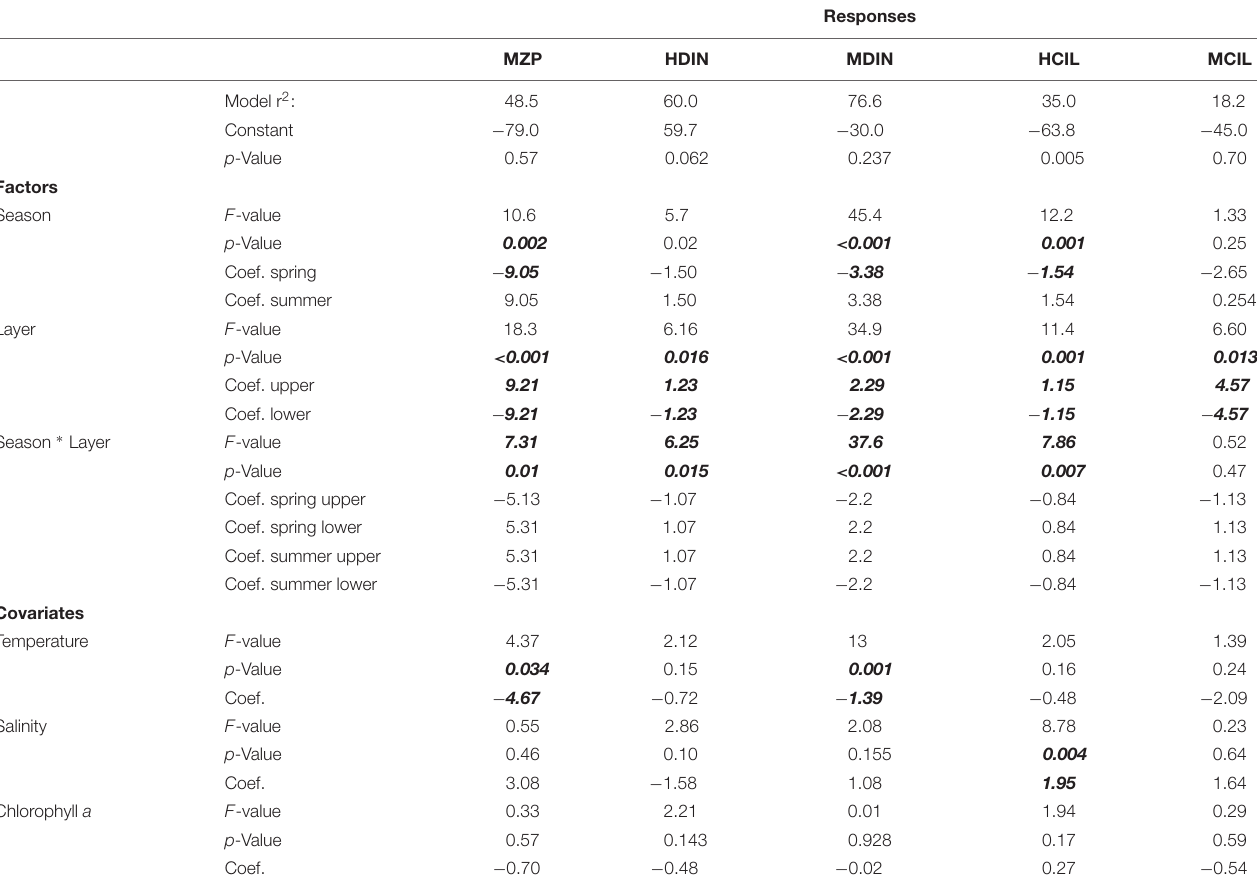
TABLE 2 | General linear model of microzooplankton biomass distribution vs. season, depth, and environmental parameters along Transect D ( n = 63).